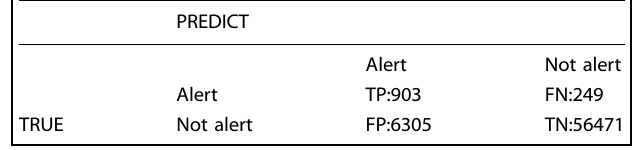
Table 7. Confusion matrix of fi nal model on fi rst fold validation set.